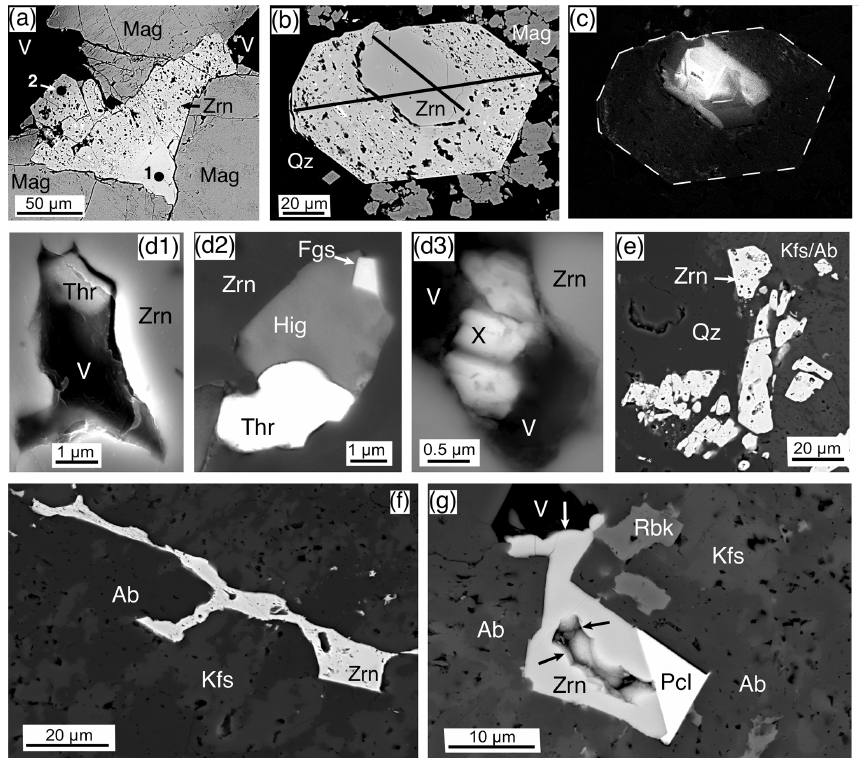
Figure 9. Hydrothermal type 2 zircons, BSE images except where noted. (a) A 175µm zircon (Zrn) filling a space between magnetite (Mag) and vugs (V) that shows the transition between type 1 (pt. 1) and type 2 (pt. 2) hydrothermal zircon. Skye, Eastern Red Hills Centre, Creag Strollamus Granite, sample H1226. (b) A 120µm euhedral zircon (Zrn) composed of an outer hydrothermal type 2 portion, filled with inclusions (e.g., calcite, REE + Y fluorcarbonate, xenotime, thorite, chlorite) around a euhedral magmatic zircon. The two crystals are inclined ∼ 50 ◦ (solid lines) and enclosed by quartz (Qz) and magnetite (Mag). Skye, Western Red Hills Centre, (Northern) Porphyritic Felsite, sample NPF (sheared) #1. (c) CL image of (b) showing a cathodoluminescence-zoned magmatic center with a weak or non-CL hydrothermal portion. Barely visible bright spots in the outer portion are thorite and REE + Y fluorcarbonate. (d1,2,3) Inclusions in hydrothermal type 2 zircon (Zrn): (d1) thorite (Thr) inclusion from sample NPF sheared #1, void (V) space, SE image; (d2) inclusion composed of fergusonite (Fgs), thorite (Thr), and probable hingganite-(Y), sample H1226; and (d3) inclusion composed of three electron beam-sensitive crystals of an unknown U,Y,Si carbonate, dark areas are void (V) space, sample H1226. (e) A group of inclusion-filled zircons (Zrn) at a quartz(Qz) and K-feldspar–albite (Kfs / Ab) boundary, and many inclusions contain thorite. Skye, Western Red Hills Centre, Glamaig Granite, sample GLE2. (f) A 100µm inclusion-filled zircon (Zrn) that formed in a gap in K-feldspar (Kfs) and albite (Ab). Skye, Western Red Hills Centre, Maol na Gainmich Granite, sample 14709. (g) A 30µm zircon (Zrn) filling a vug (V) after the precipitation of fluornatropyrochlore (Pcl). The cavity in the zircon has a botryoidal surface (black arrows), as well as the upper portion (white arrow). The Zrn and Pcl are enclosed by K-feldspar (Kfs) and albite (Ab) accompanied by riebeckite (Rbk). Ailsa Craig microgranite, sample